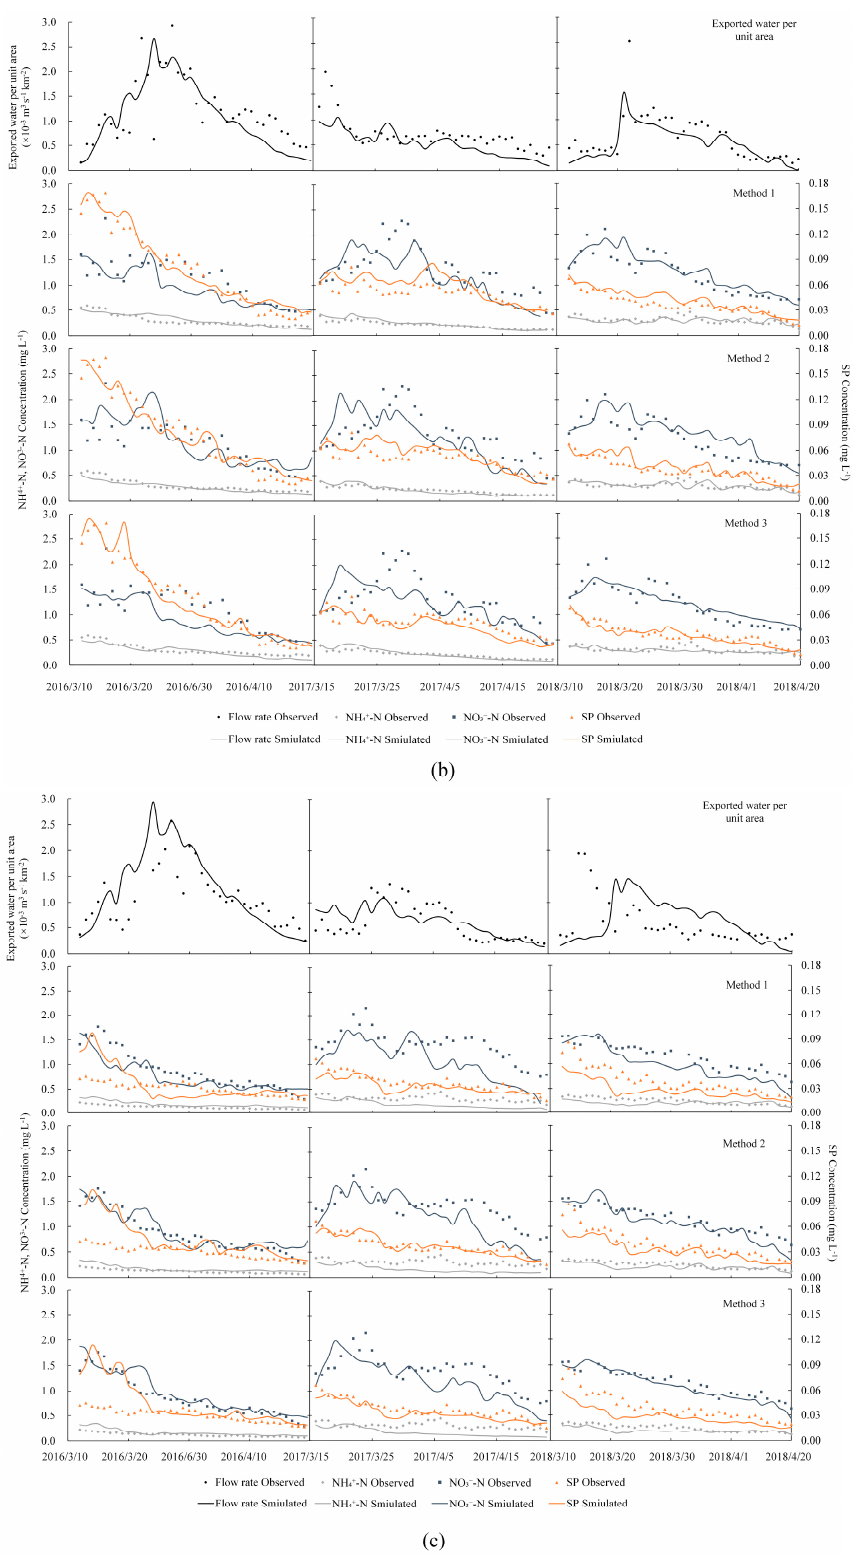
Figure 4. Measured and simulated values of water and pollutants exported from soil into streams.